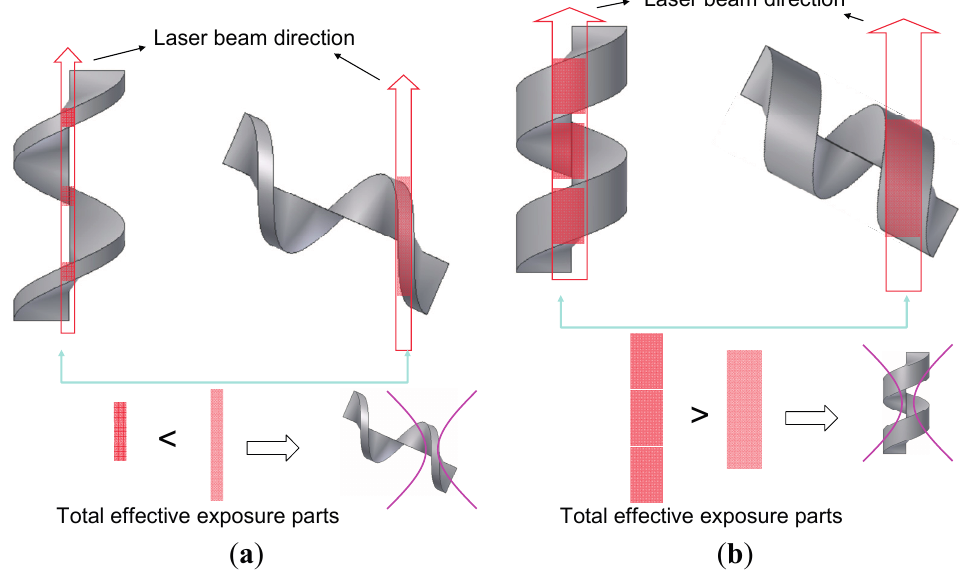
Figure 7. Schematic explanation of the influence of blade thickness: ( a ) thin-blade screw; ( b ) thick-blade